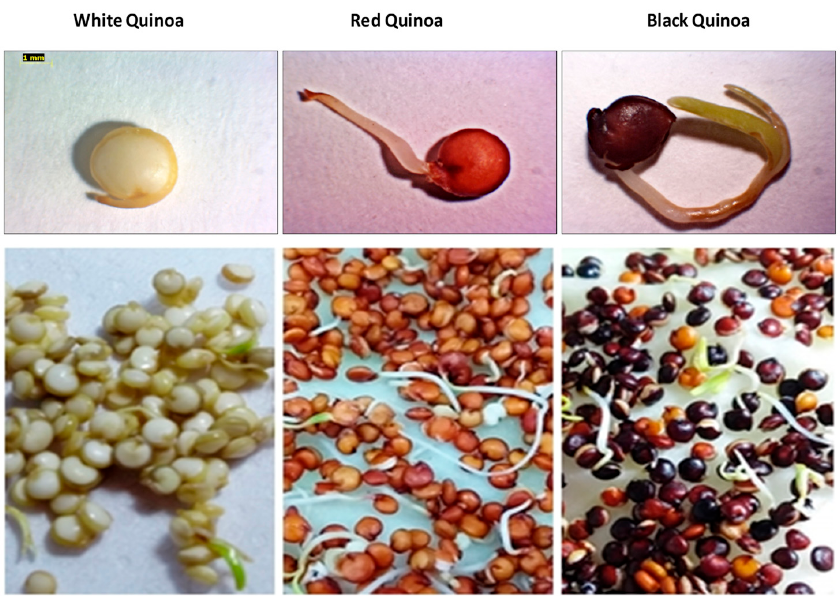
Figure 1. Germinated of white, red and black quinoa ( Chenopodium quinoa Willd) at 24 h of germination (G1).